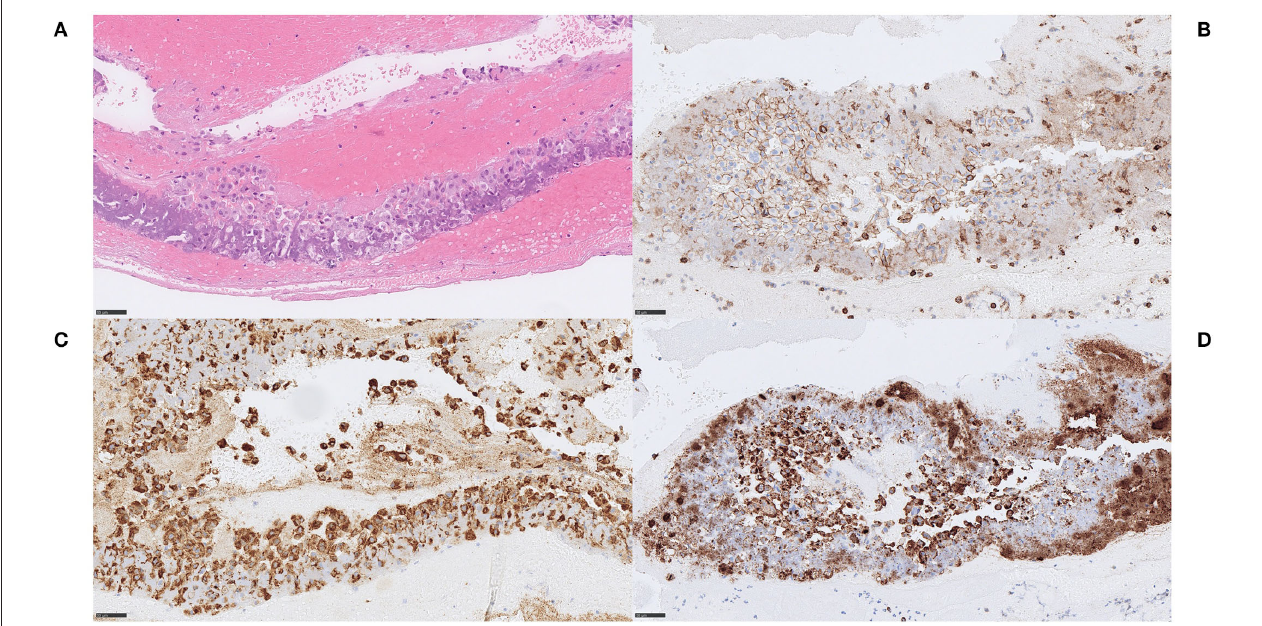
FIGURE 2 | Extracellular DNA (ecDNA) with calcifications. Large calcific type. Case 1.2: The cell population that was identified in relation to ecDNA and large calcific plaques showed various morphology of both moderately large cells with abundant cytoplasm, rounded and eccentrically placed nuclei with pale, evenly distributed chromatin, suggestive of macrophages (A) H&E, 400x, as well as spindle-shaped cells with long, very eosinophilic cytoplasmic extensions reminiscent of myofibroblats (not shown). However, all cells showed the same immunophenotype of strong immunoreactivity for the pan-leukocytic marker CD45 (B) CD45, 400x, the macrophage marker CD68 (C) CD68PG, 400x and the smooth muscle cell marker α -SMA (D) , α -SMA, 400x, indicative of a macrophage-to-myofibroblast transition. Considering the amounts of ecDNA and the type of cells present in these thrombi, the ecDNA may represent a type of monocyte-extracellular traps (METs). S cale bar = 50 µ m